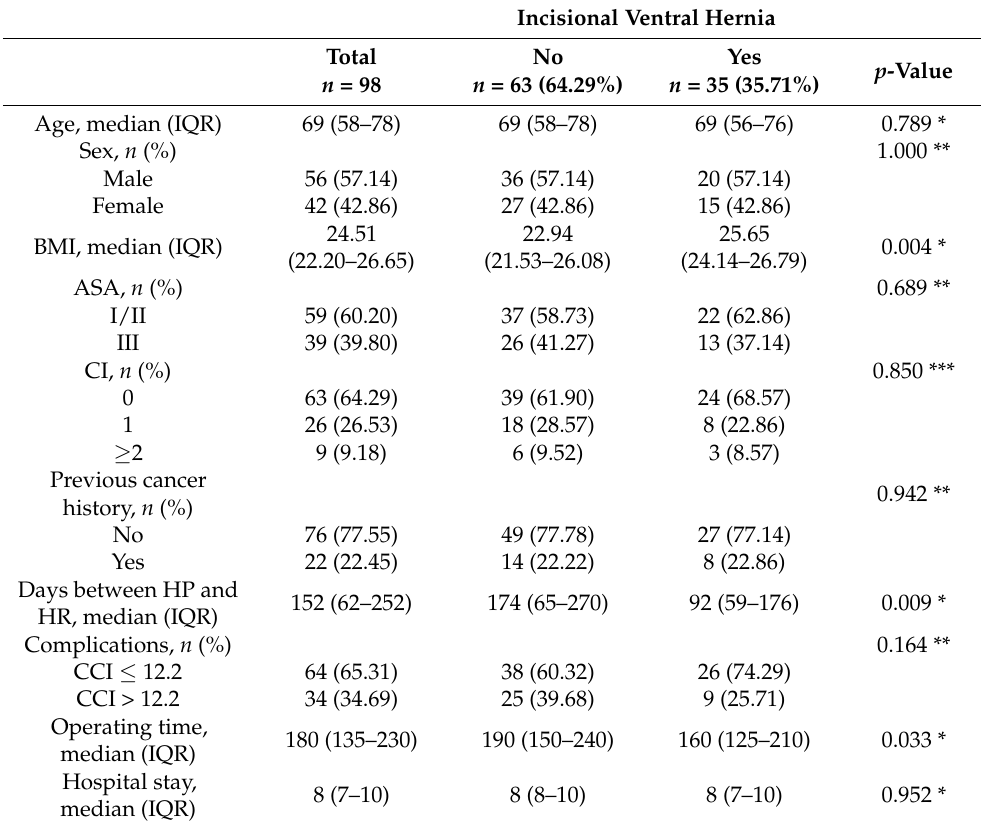
Table 5. Characteristics of the sample stratified based on the absence/presence of Incisional Ventral Hernia (IVH).